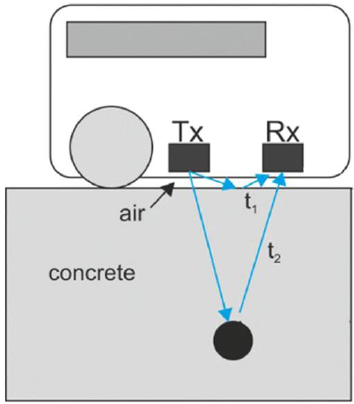
Figure 3. Reflection of incident wave at concrete–bar interface [98].